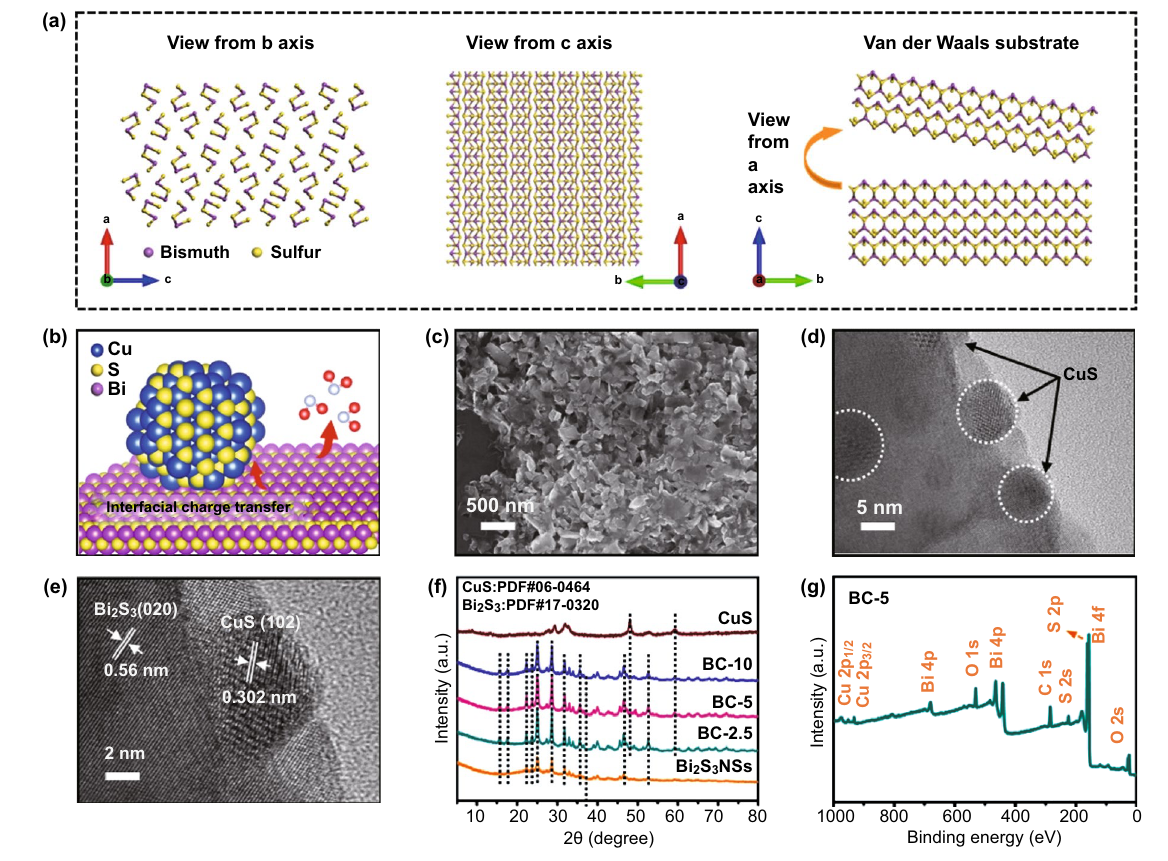
Fig. 3 CuS QDs/Bi 2 S 3 NSs heterostructure and characterization of CuS and Bi 2 S 3 NSs. a Schematic diagram of crystal structure and fracture- exfoliation process of Bi 2 S 3 bulk material with selective orientation. b Schematic representation of the atomic structure of CuS QDs/ Bi 2 S 3 NSs. c‑e SEM, TEM and HR-TEM images of BC-5. f XRD patterns of CuS QDs/Bi 2 S 3 NSs, CuS and Bi 2 S 3 NSs. g Full XPS survey spectrum of